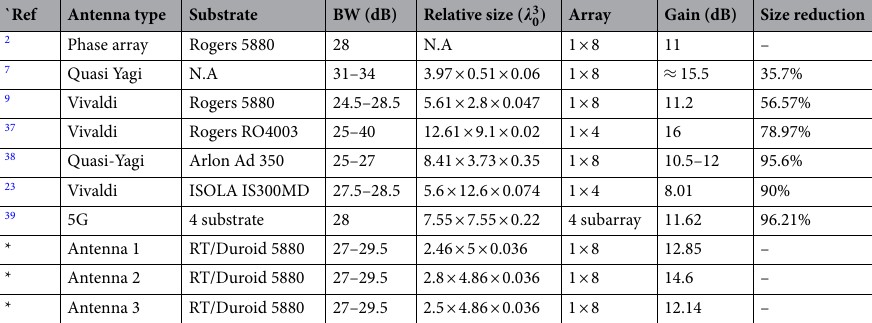
Table 6. Comparison of three antenna results with other references of